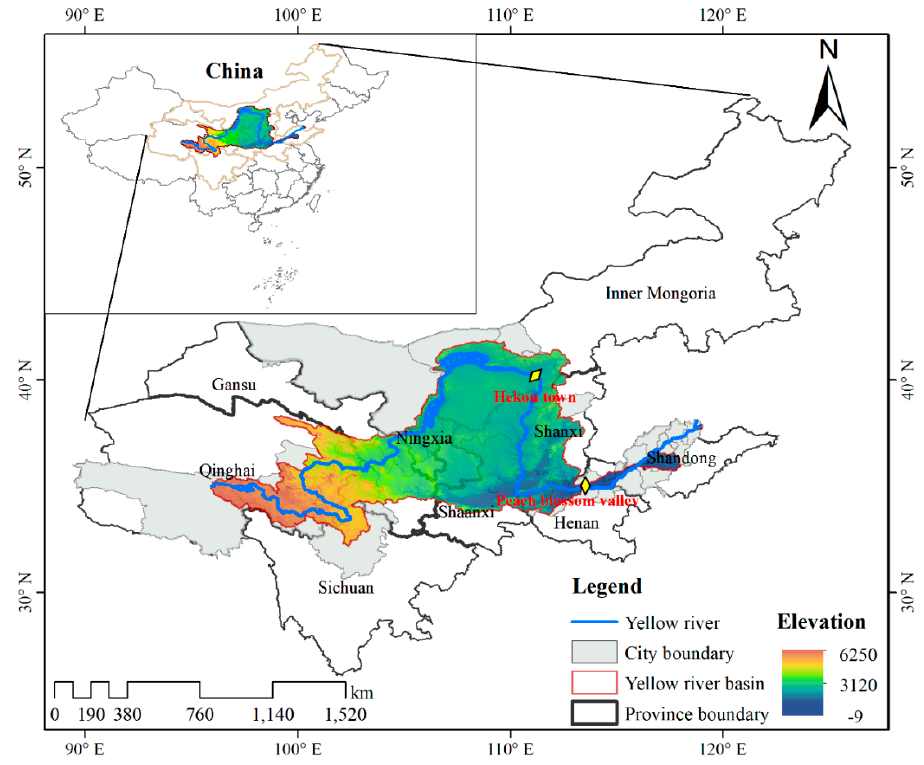
Figure 2. Map of the Yellow River Basin, China.